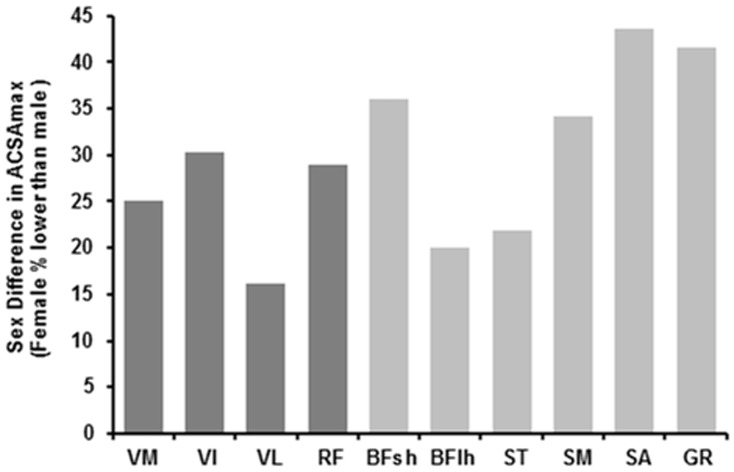
The magnitude of the sex difference for individual KE (dark grey) and KF (light grey) muscles.Data are presented as mean female ACSAmax (n = 34) as the percentage less than mean male ACSAmax (n = 32). The sex difference ranged from 16.1% for the VL to 43.6% for the SA.